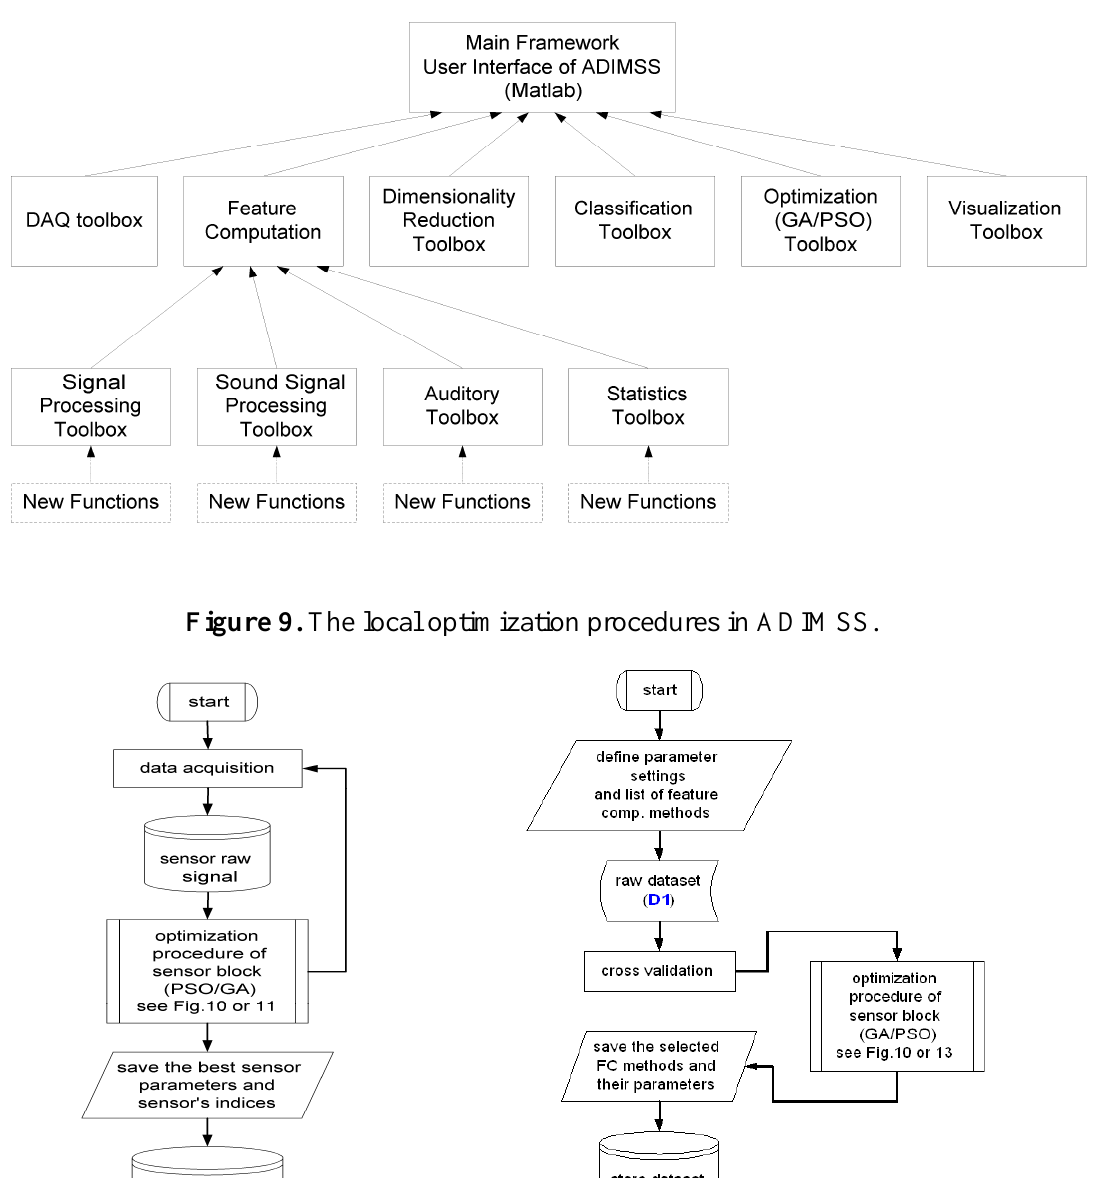
Figure 8. The list of toolboxes used in ADIMSS framework.